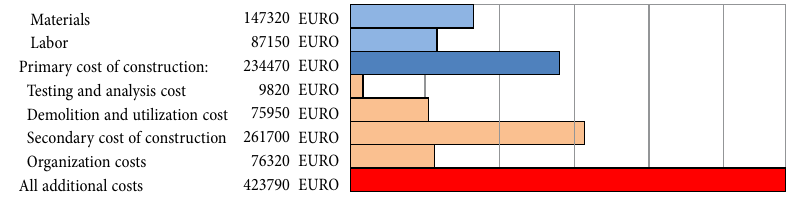
Fig. 1. Summary of the costs and losses for damage to the floor in the shopping center (11.120 m 2 ) (own study)